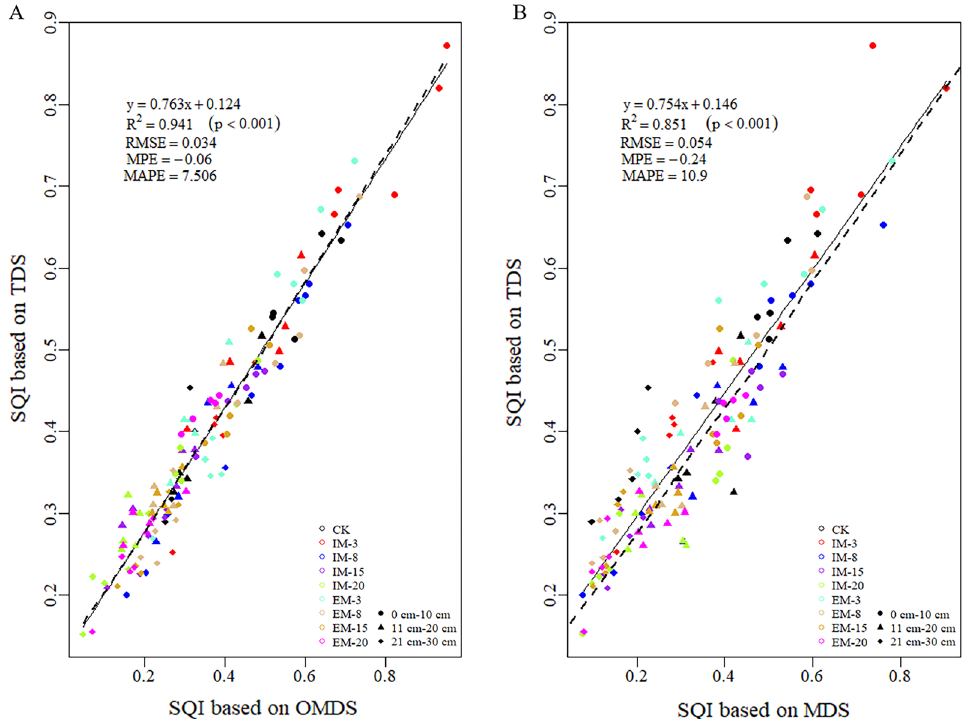
Figure 3. Linear relationships between SQI-TDS and SQI-OMDS ( A ), SQI-TDS and SQI-MDS ( B ). RMSE root mean squared error, MPE mean predictive error, MAPE mean absolute percentage